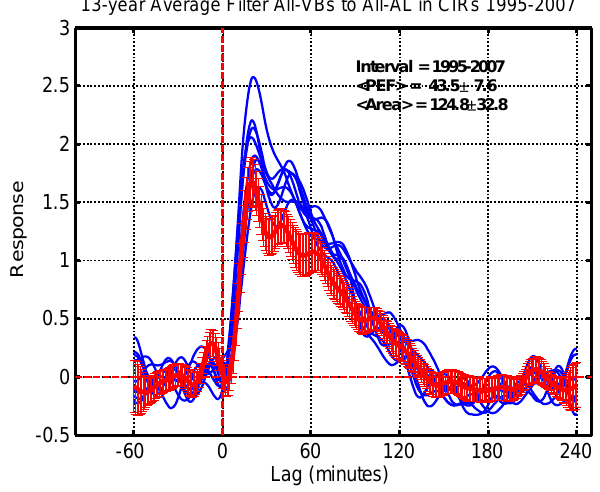
Figure 6. Ensemble average linear prediction filters relating VBs to AL index during the Fig. 6. Ensemble average linear prediction filters relating V B s to interval 1995-2007. Each trace shows a different day relative to a stream interface. The AL index during the interval 1995–2007. Each trace shows a differ- heavy red line shows the error of the mean of all filters on the filter spanning the CIR ent day relative to a stream interface. The heavy red line shows the stream interface. The filter has been inverted for display purposes. error of the mean of all filters on the filter spanning the CIR stream interface. The filter has been inverted for display purposes.